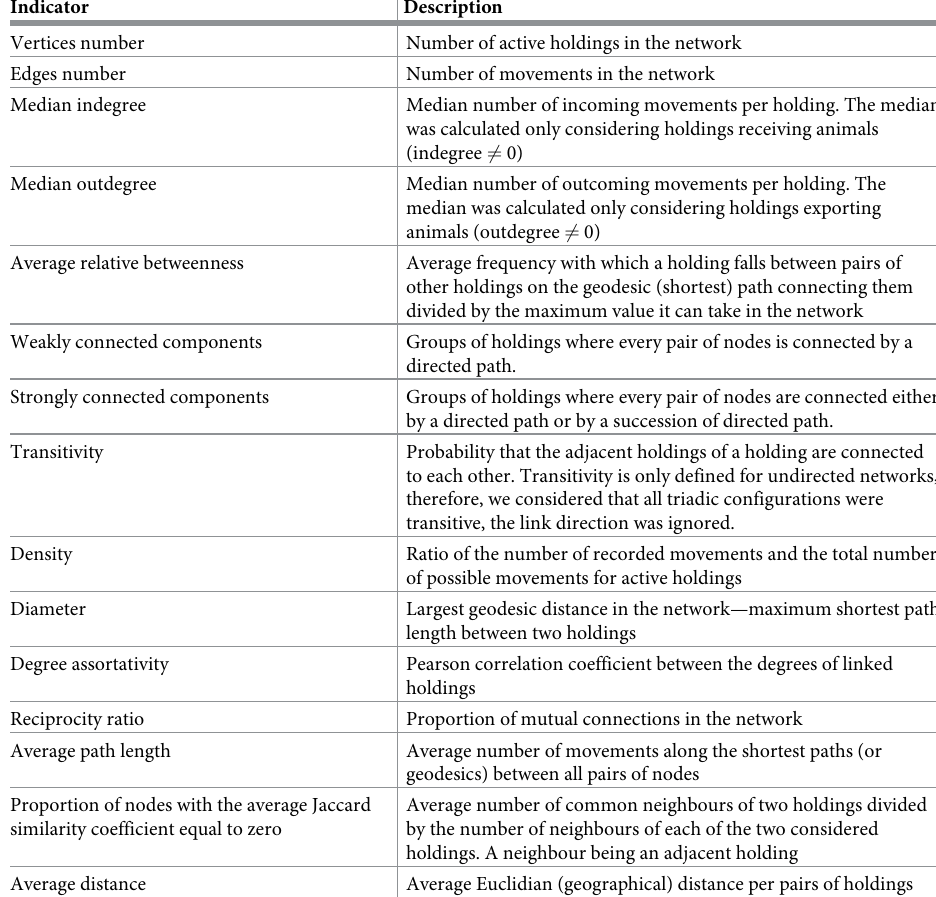
Table 2. Networks metrics calculated for each network to analyse network